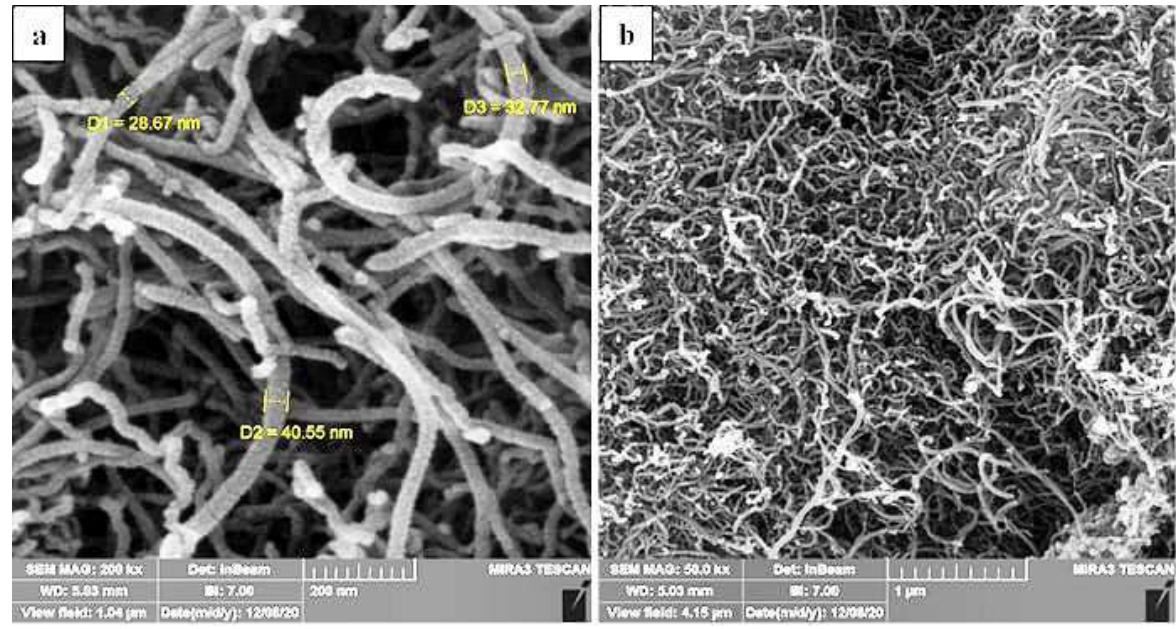
Figure 4: FESEM images of F-MWCNTs with different magnifications at a) scale bar = 200 nm and b) scale bar =1